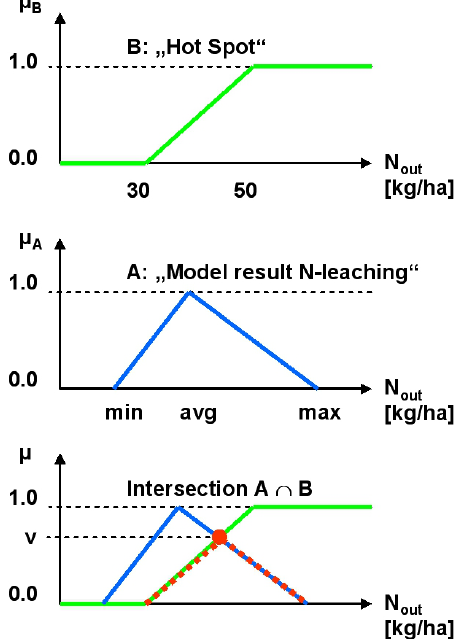
Fig. 6. Definition of nitrogen leaching hot spots for the Elbe River Basin; top panel: fuzzy number B=“hot spot”; middle panel: fuzzy number A=“model results”; bottom panel: fuzzy number that “model result” belongs to “hot spot”.